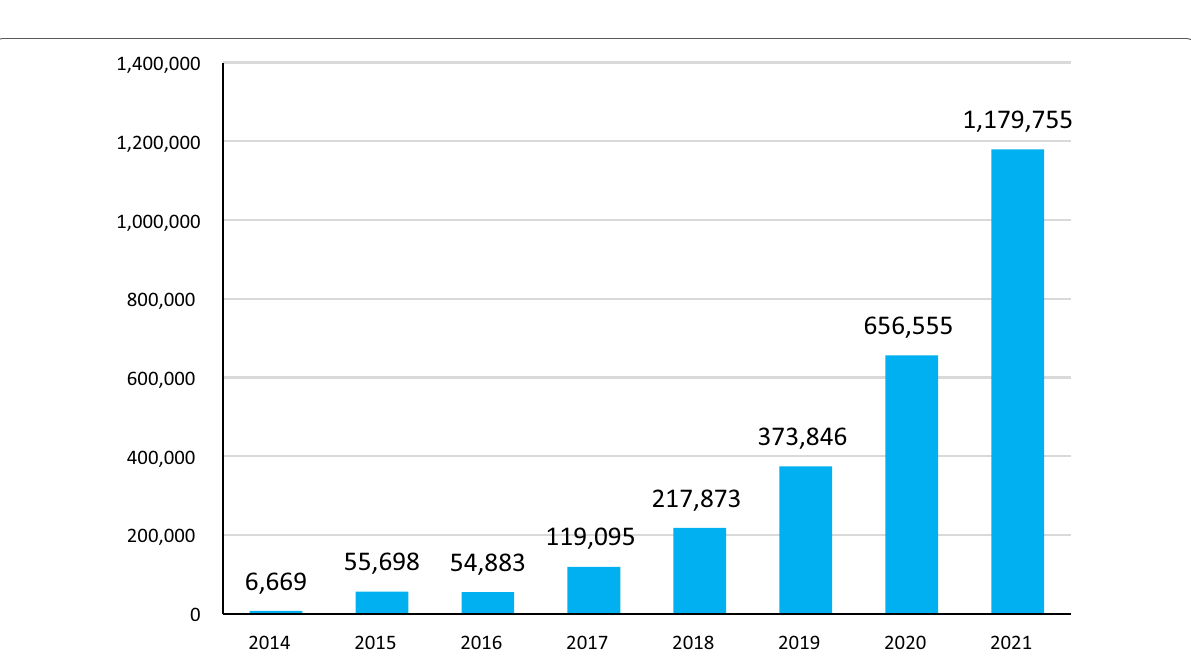
Fig. 3 Number of full-text accesses* by calendar year (Source: Springer). * Accesses are defined as the number of times full text or PDF versions of articles are accessed directly from the journal website and SpringerLink. Downloads are defined as HTML, LookInside, PDF, and Epub clicks.